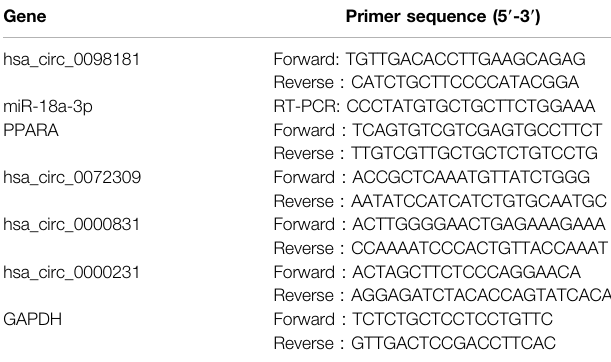
TABLE 1 | Primers for the